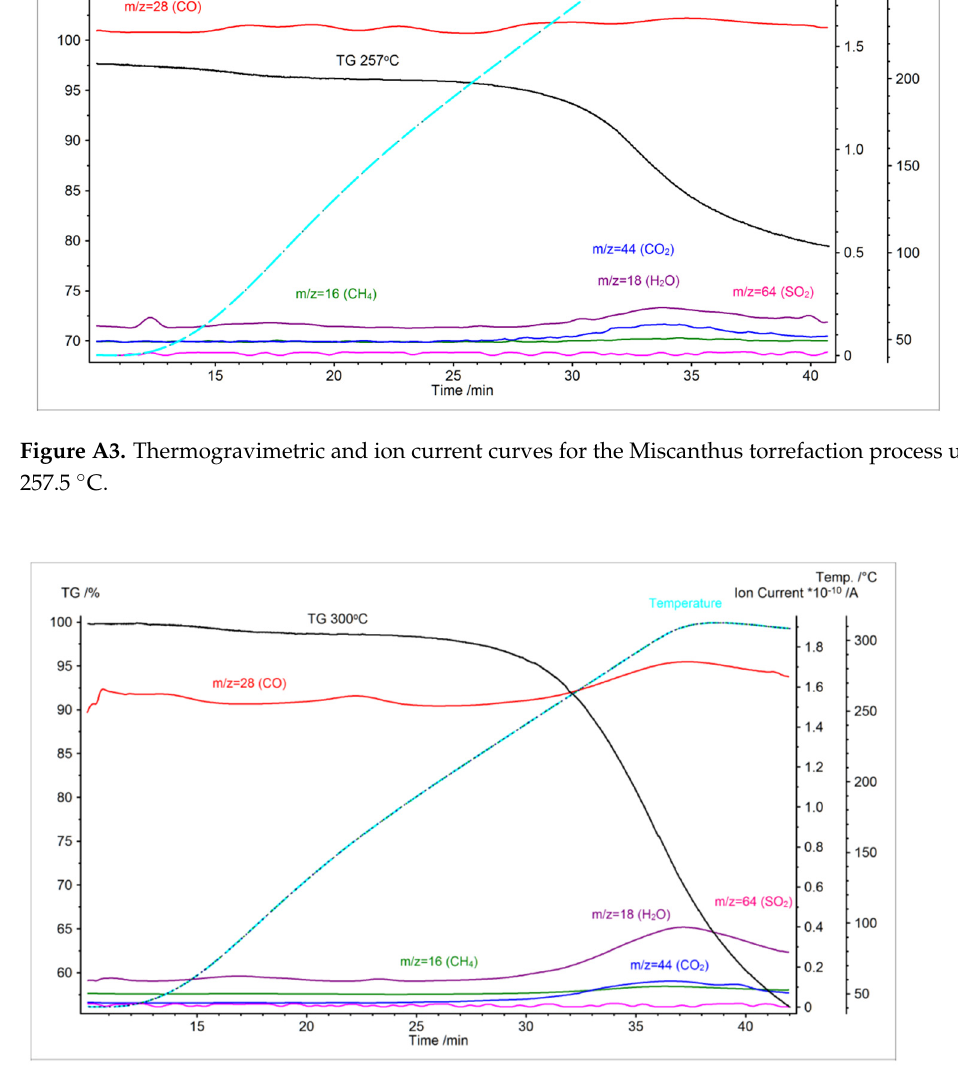
Figure A4. Thermogravimetric and ion current curves for the Miscanthus torrefaction process up to 300 °C.